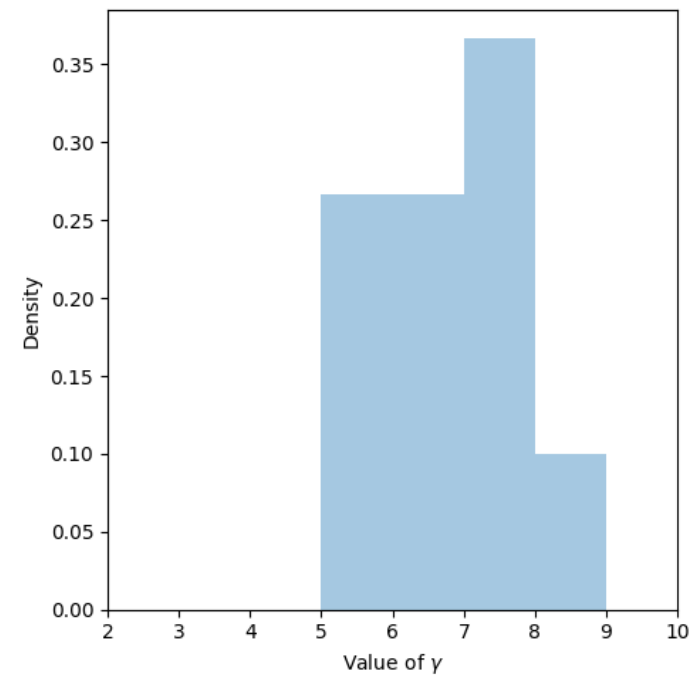
Figure 11. Distribution of the optimal γ values identified by our